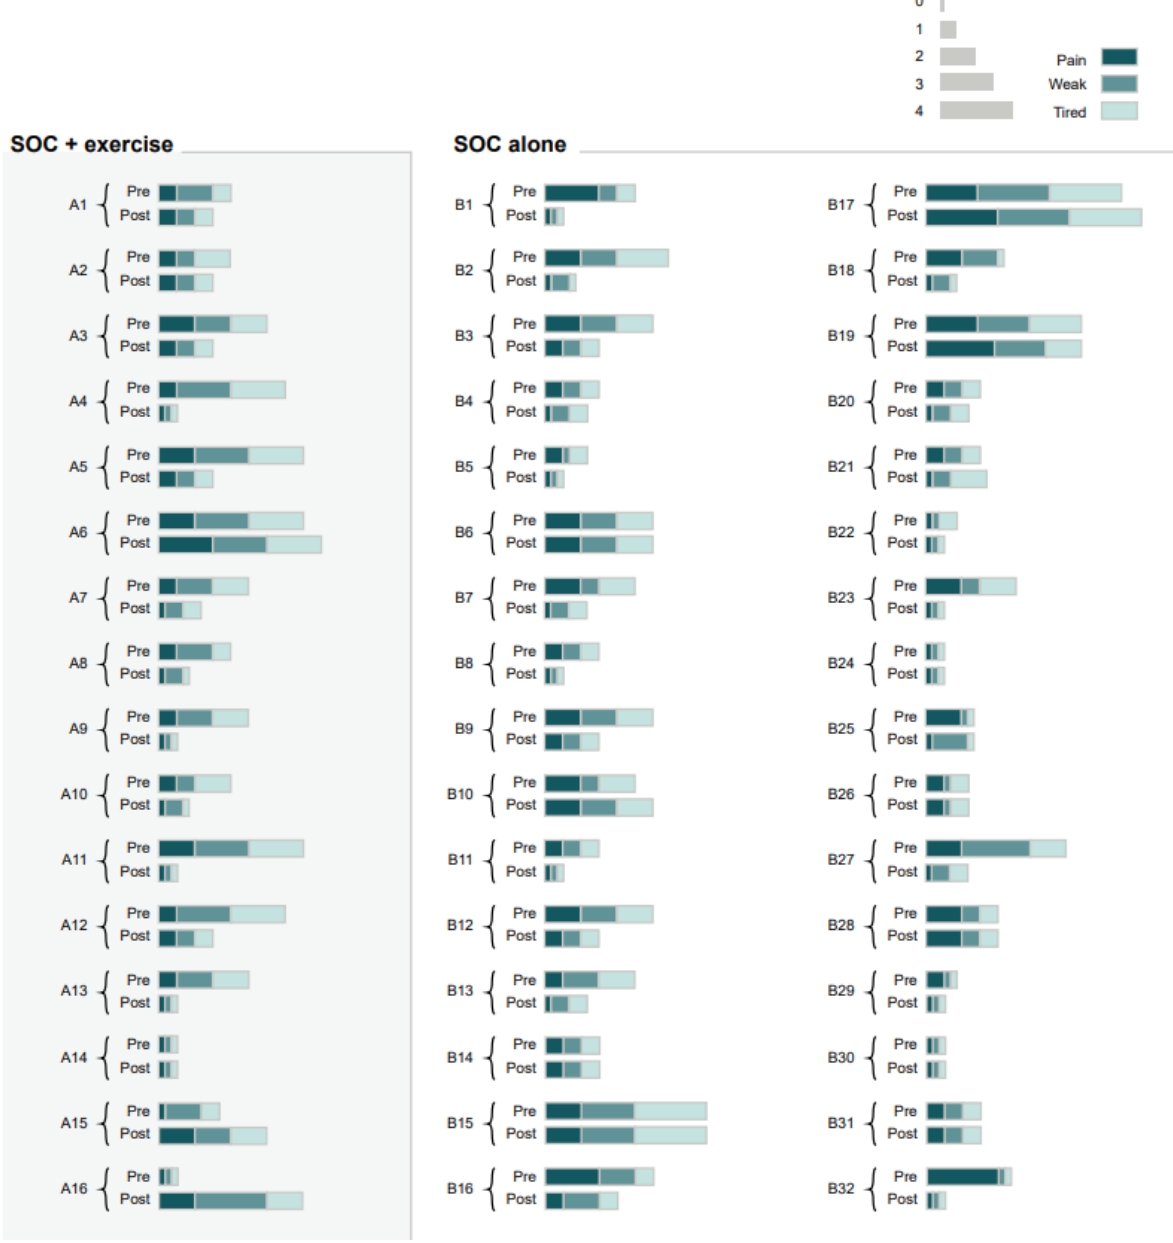
Figure 6. Heatmap illustrating patient-reported physical item scores at discharge for individual study participants (within their respective group) before and after the single short bout. Different coloring indicates self-reported physical items: pain, weak, tired. The width of the color corresponds to the score of each parameter (0 = minimal, 4 = maximum). SOC, standard of care; SOC+Ex, standard of care plus exercise.